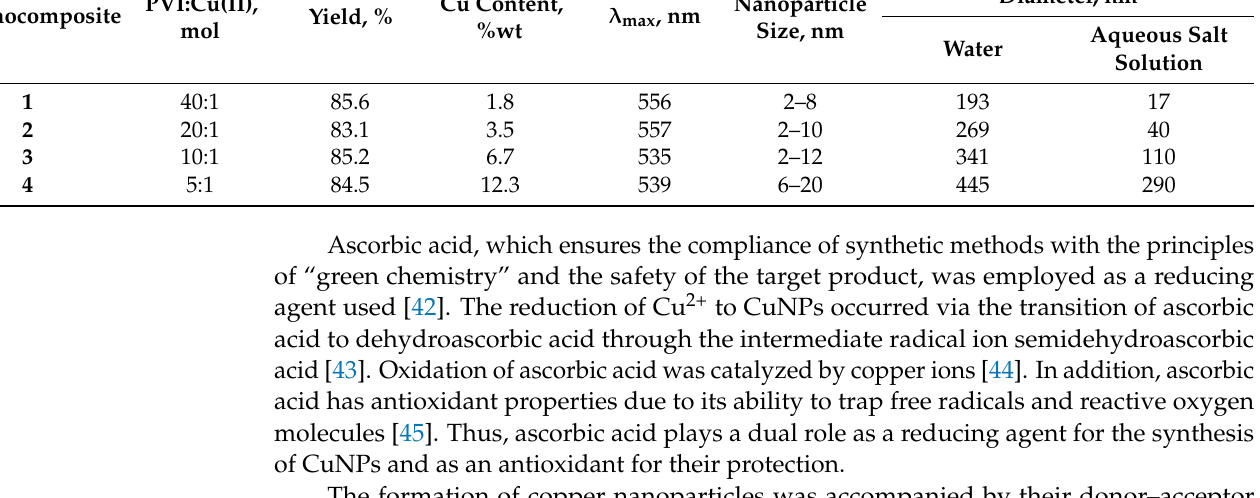
Table 1. Composition and characteristics of the nanocomposites with CuNPs 1–4 .